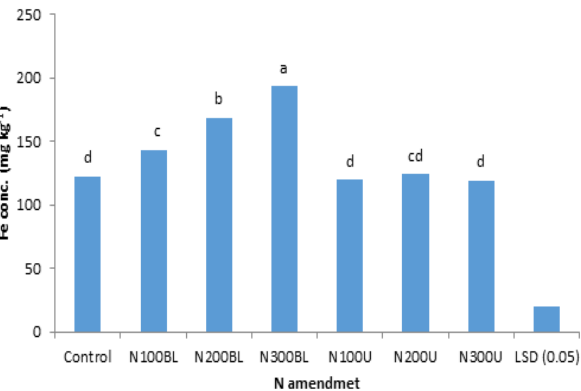
Fig. 1. Fe and Mn concentration of silage corn in 2008 and 2009. Means with the different letters show significant difference (LSD, P ≤ 0.05)